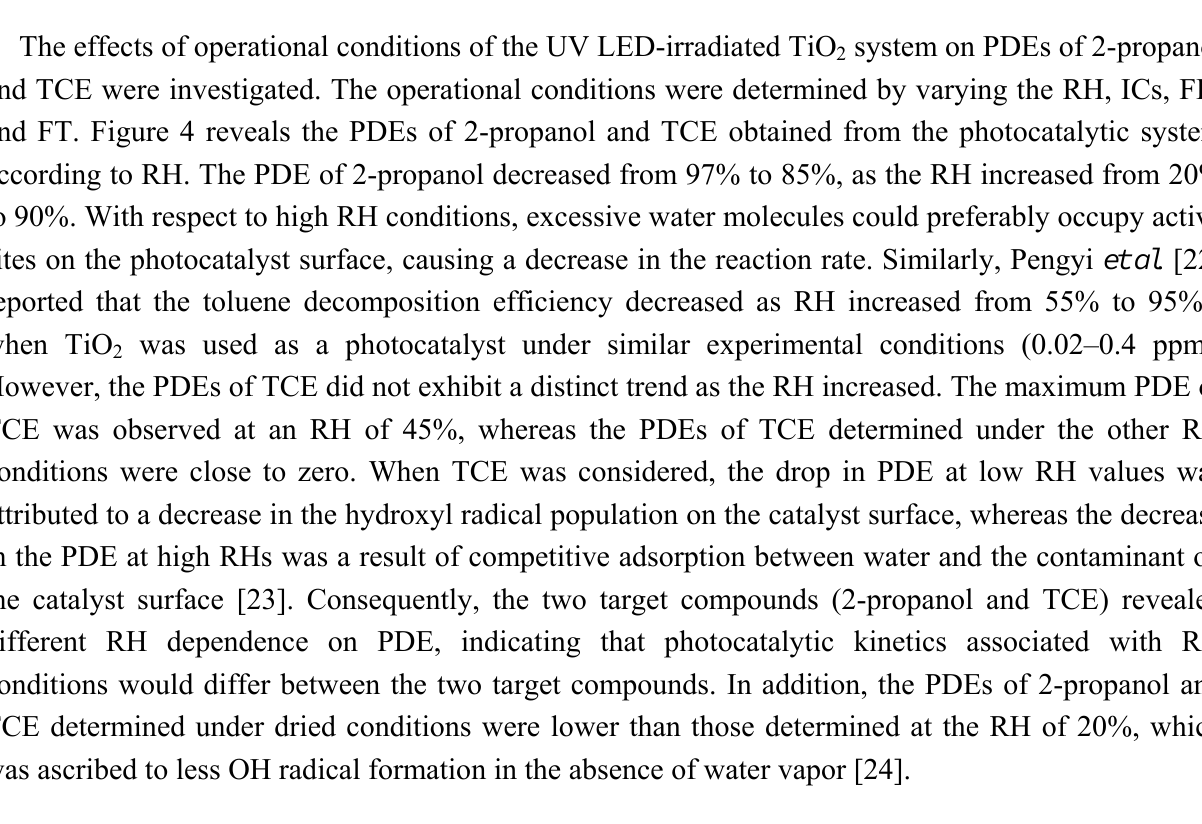
Figure 4. Time-series photocatalytic efficiencies (PDEs, %) of ( a ) 2-propanol; and ( b ) TCE as calcined at 450 o C according to relative humidity (20, 45, 70, and determined using TiO 2